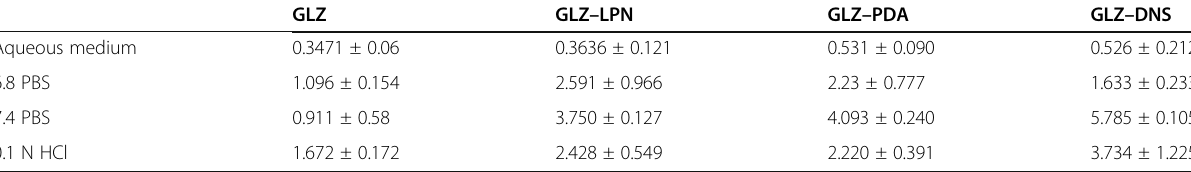
Table 3 Solubility results of GLZ, GLZ – DNS, GLZ – PDA, and GLZ – LPN in a different dissolution